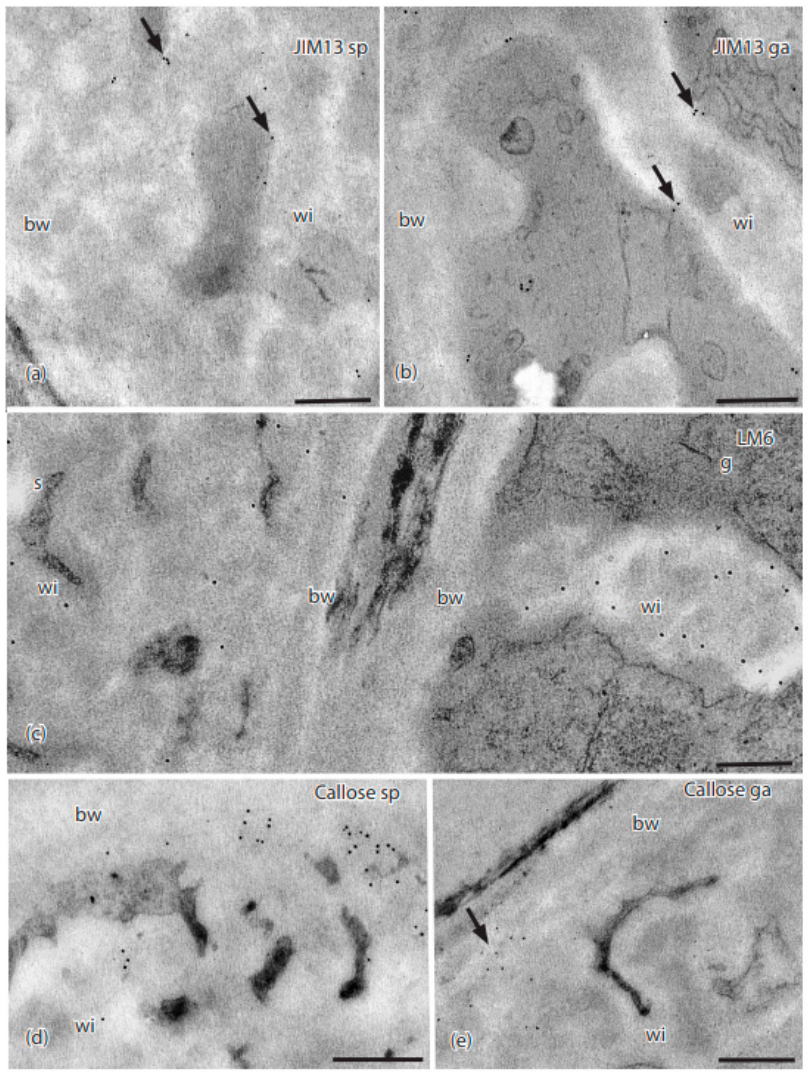
Figure 5. TEMs of Physcomitrium patens placenta showing immunogold labeling with monoclonal antibodies to AGP and callose epitopes. ( a ) In the sporophyte placental transfer cell, JIM13 labels (arrows) occurred along the plasma membrane and wall ingrowths (wi), but not in the basal wall layer (bw). ( b ) Labels for JIM13 (arrows) occurred in the gametophyte along the plasma membrane and wall ingrowths (wi), but not in the basal wall (bw). ( c ) LM6 labels were scattered throughout the wall ingrowths (wi) and basal wall (bw) in the sporophyte (s), and mostly in the electron-lucent area along the edges of the wall ingrowths (wi) in the gametophyte (g) side, with few labels in the basal wall (bw). ( d ) Sporophyte and ( e ) gametophyte; labels for anti-callose (arrows) appeared along the outer edge of the basal wall (bw) where it came into contact with the wall ingrowths, with few labels in wall ingrowths (wi). Scale bars = 0.5 µm.